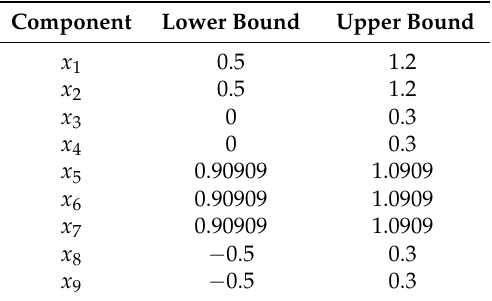
Table 9. The bound constraints for decision variables in